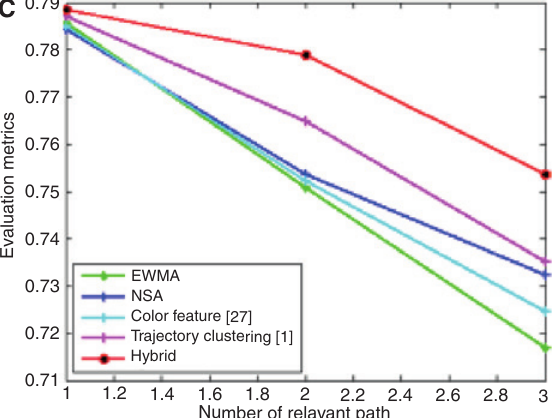
Figure 10: Performance Analysis of Video Object Retrieval for Video 5. (A) Video 5-Precision, (B) Video 5-Recall and (C) Video